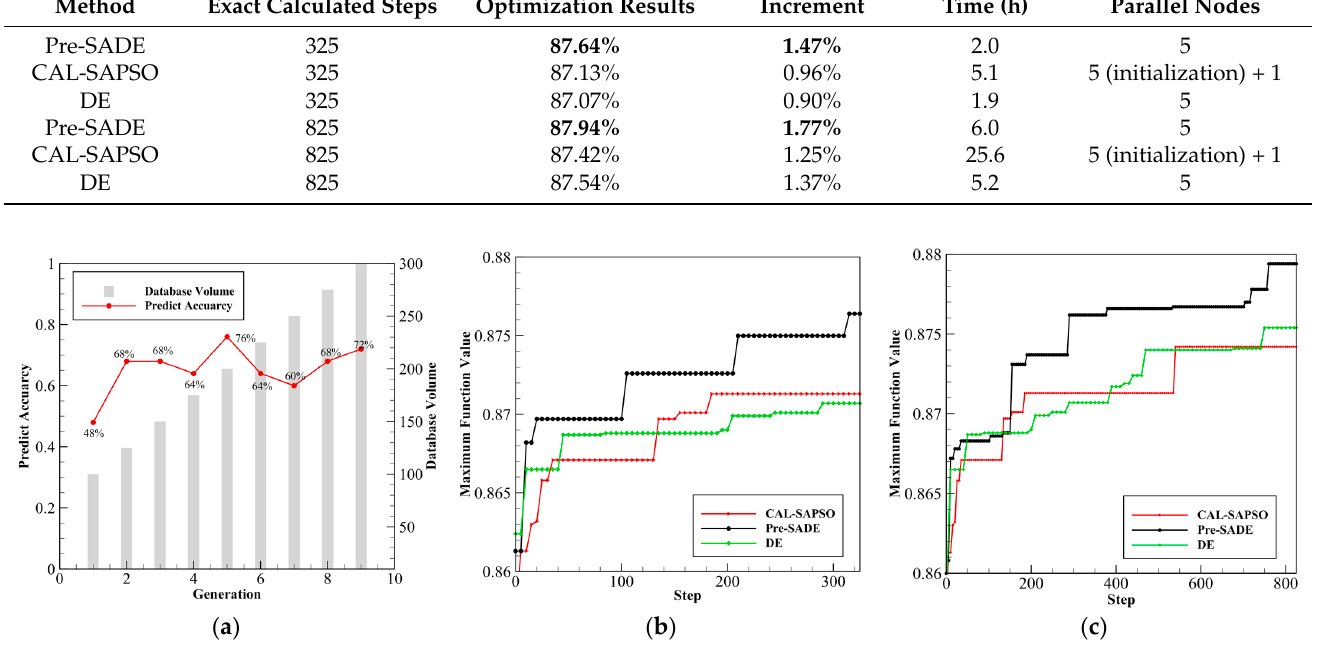
Figure 9. The predicting accuracy of the surrogate model and the optimization history. ( a ) The predicting accuracy of the trained surrogate model. ( b ) The optimization history of 325 steps. ( c ) The optimization history of 825 steps.